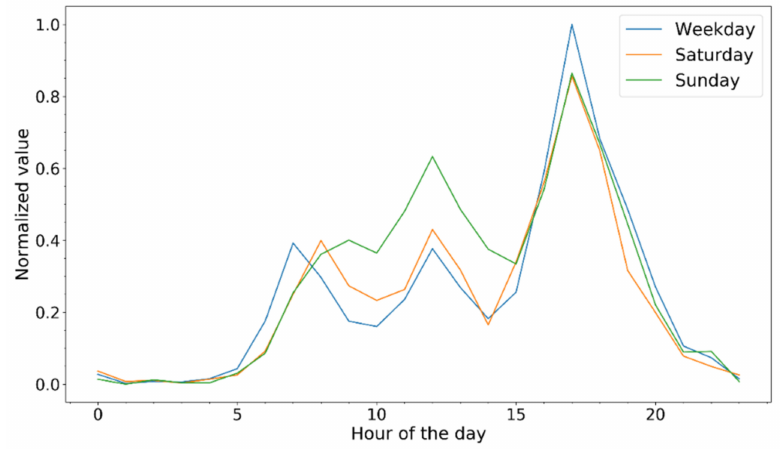
Figure A5. Average activity profile from time-use survey (TUS) data for the activity cooking in the United Kingdom in spring season. To build activity profiles, we analyze TUS data to develop shares for each hour of the day of how many persons perform a certain activity. From this, we differentiate the data by age, gender, weekday, and season and scale them with real population data to represent a country’s average. The cooking profile shows its peak in the evening between 17:00 and 18:00 and a noon peak at 12:00. The noon peak is more pronounced on Sunday, while the evening peak is more pronounced on weekdays.